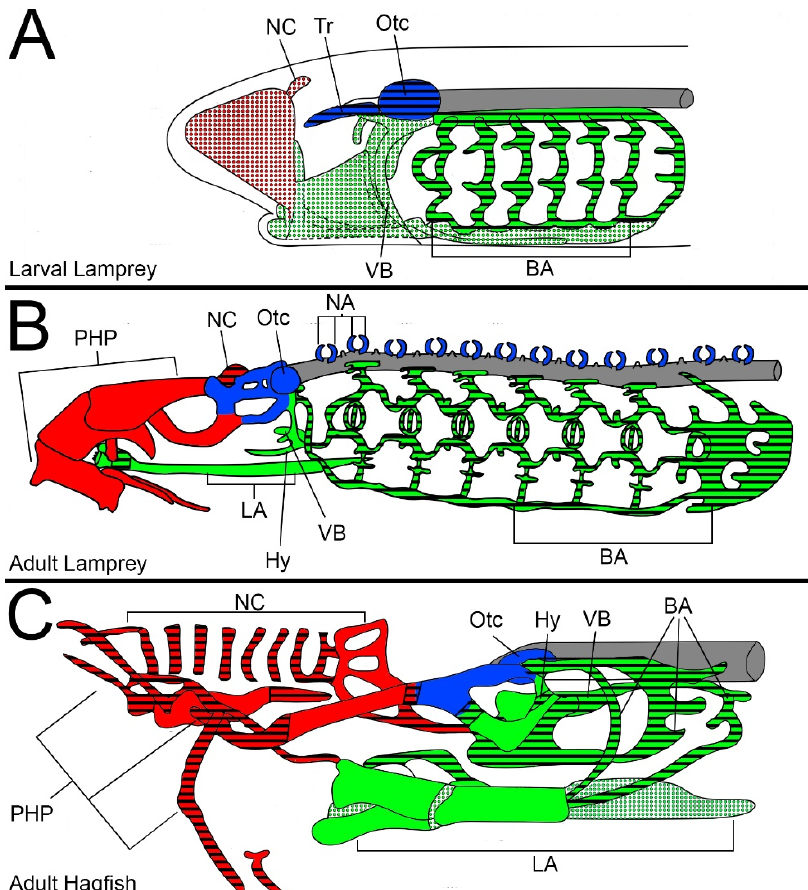
Figure 1. Overview of cyclostome cartilaginous head skeletons. ( A ) Larval lamprey. ( B ) Adult lam- prey. ( C ) Adult hagfish. Colors correspond to suggested tissue contributions. Red: Pre-mandibular neural crest. Green: Mandibular/Post-mandibular neural crest. Blue: Mesoderm. Textures corre- spond to distinctions in cartilage type. Solid color: hard cartilage. Color with black stripes: soft cartilage. White with colored spots: cartilage-like tissues. Cartilage distinctions for larval and adult lampreys are adapted from Parker (1888) and Johnel (1948) illustrations and descriptions. Cartilage distinctions for hagfishes are adapted from Cole (1905) illustrations and descriptions. Keywords: BA: branchial arches; Hy: hyoid; LA: lingual apparatus; NA: neural arches; NC: nasal cartilage(s);